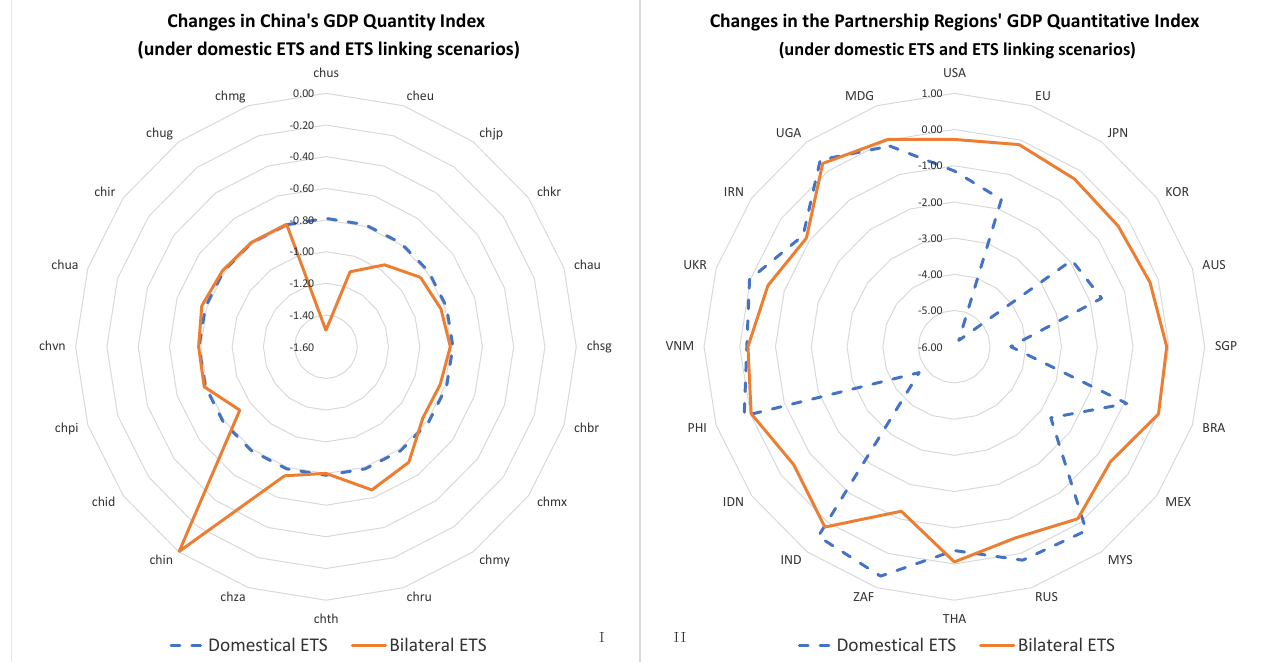
Figure 7. Changes in China’s real GDP in various scenarios of international bilateral ETSs. ( I , II ), Real GDP (gross domestic production) changes in China ( I ) and its partner regions ( II ) under domestic ETS and ETS linking scenarios.